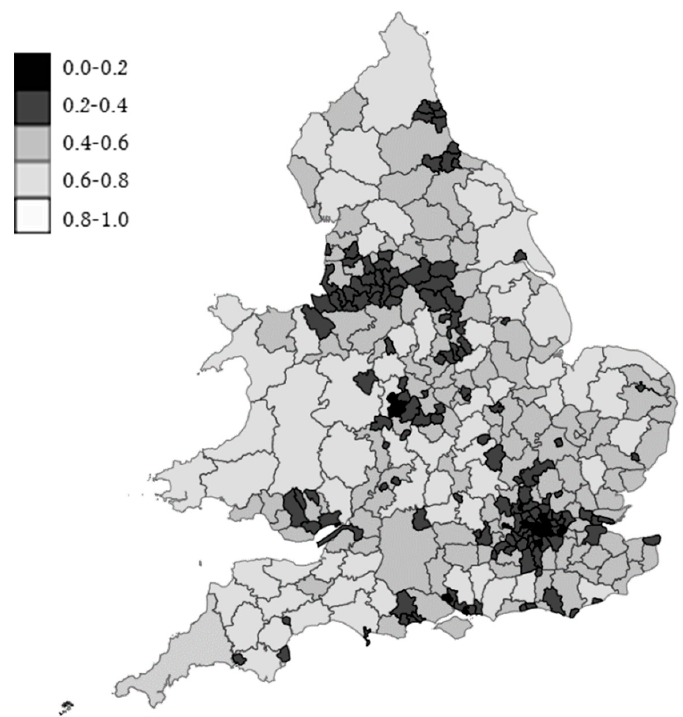
Figure 2. Local authority units across England and Wales color mapped based on their respective Gini coefficients—Contains OS data © Crown copyright and database rights 2016.